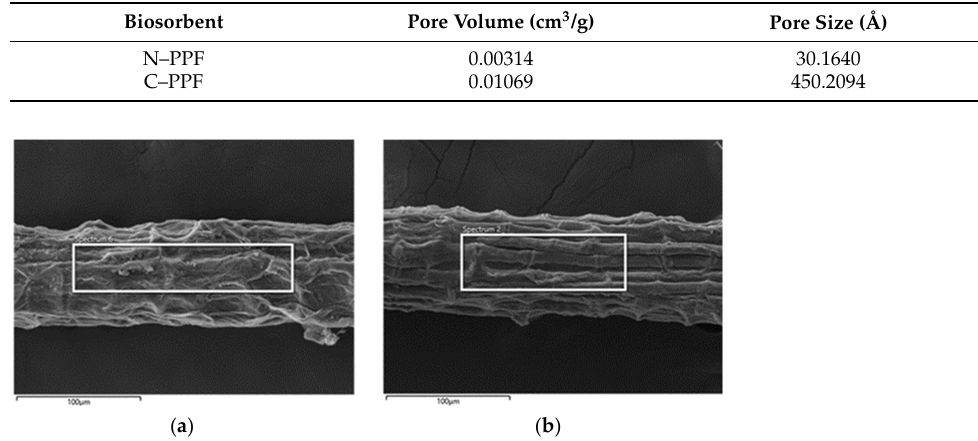
Table 1. Specific surface area, pore volume, and pore size of the biosorbents.